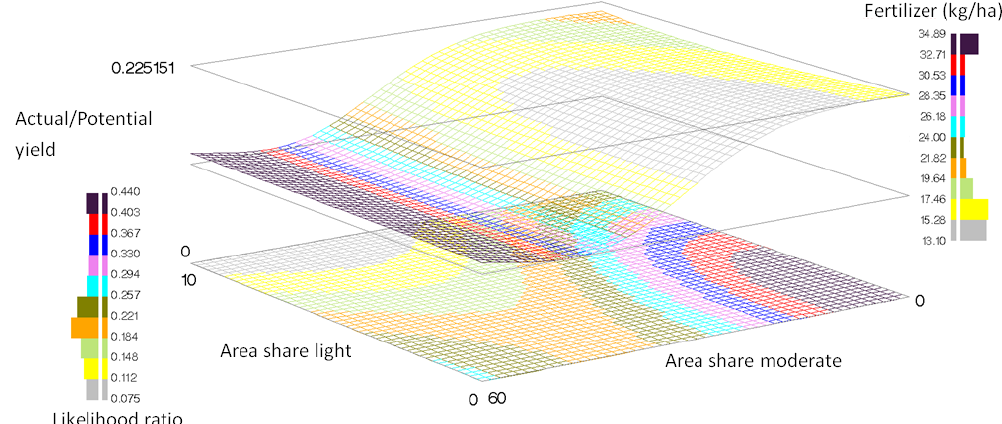
Figure 2. Yield ratio (actual / potential yield) against area share under light and moderate degradation; covariates: fertilizer applications and likelihood ratio.